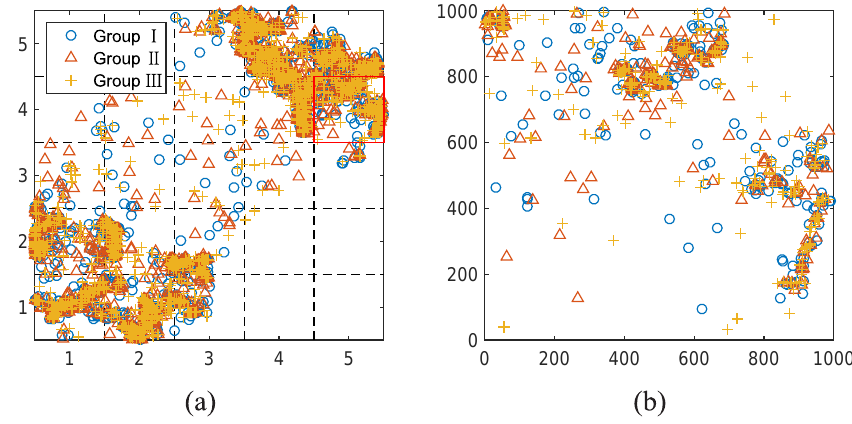
Figure 8. ( a ) Distribution of 6000 nodes (Groups I,II, and III ) over the whole 5 × 5 km 2 region which is divided into 25 unit squares; ( b ) Distribution of crowdsensing nodes over the unit area indicated by the red box in ( a ).